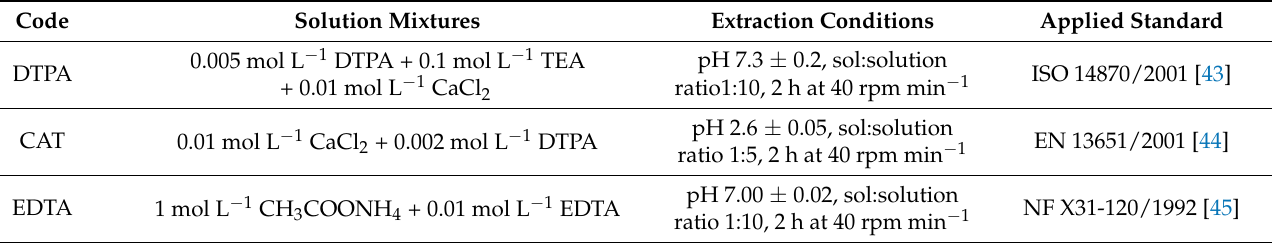
Table 3. Chemical conditions for bioavailable fraction